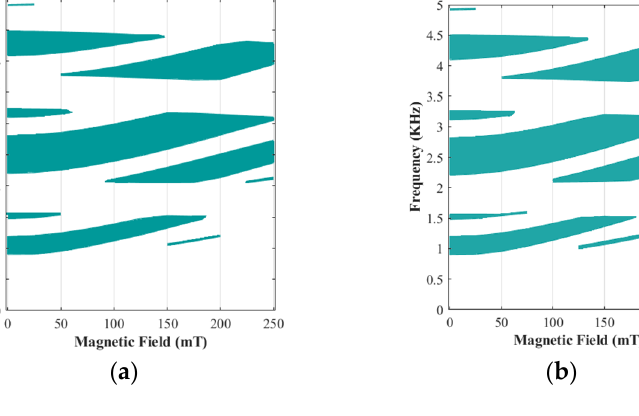
Figure 14. Evolution of active bandgap areas in different magnetic fields ( 0 (cid:3407) 𝐵 (cid:3407) 250 mT ) with the various iron volume fraction, fixed cylindrical core radius of 𝐿 𝑅 ⁄ (cid:3404) 8 , and the fixed arm angle 𝜃 (cid:3404) (cid:3398) 1 ° : ( a ) 𝜙 (cid:3404) 6.08% ; ( b ) 𝜙 (cid:3404) 13.94% ; ( c ) 𝜙 (cid:3404) 18.48%